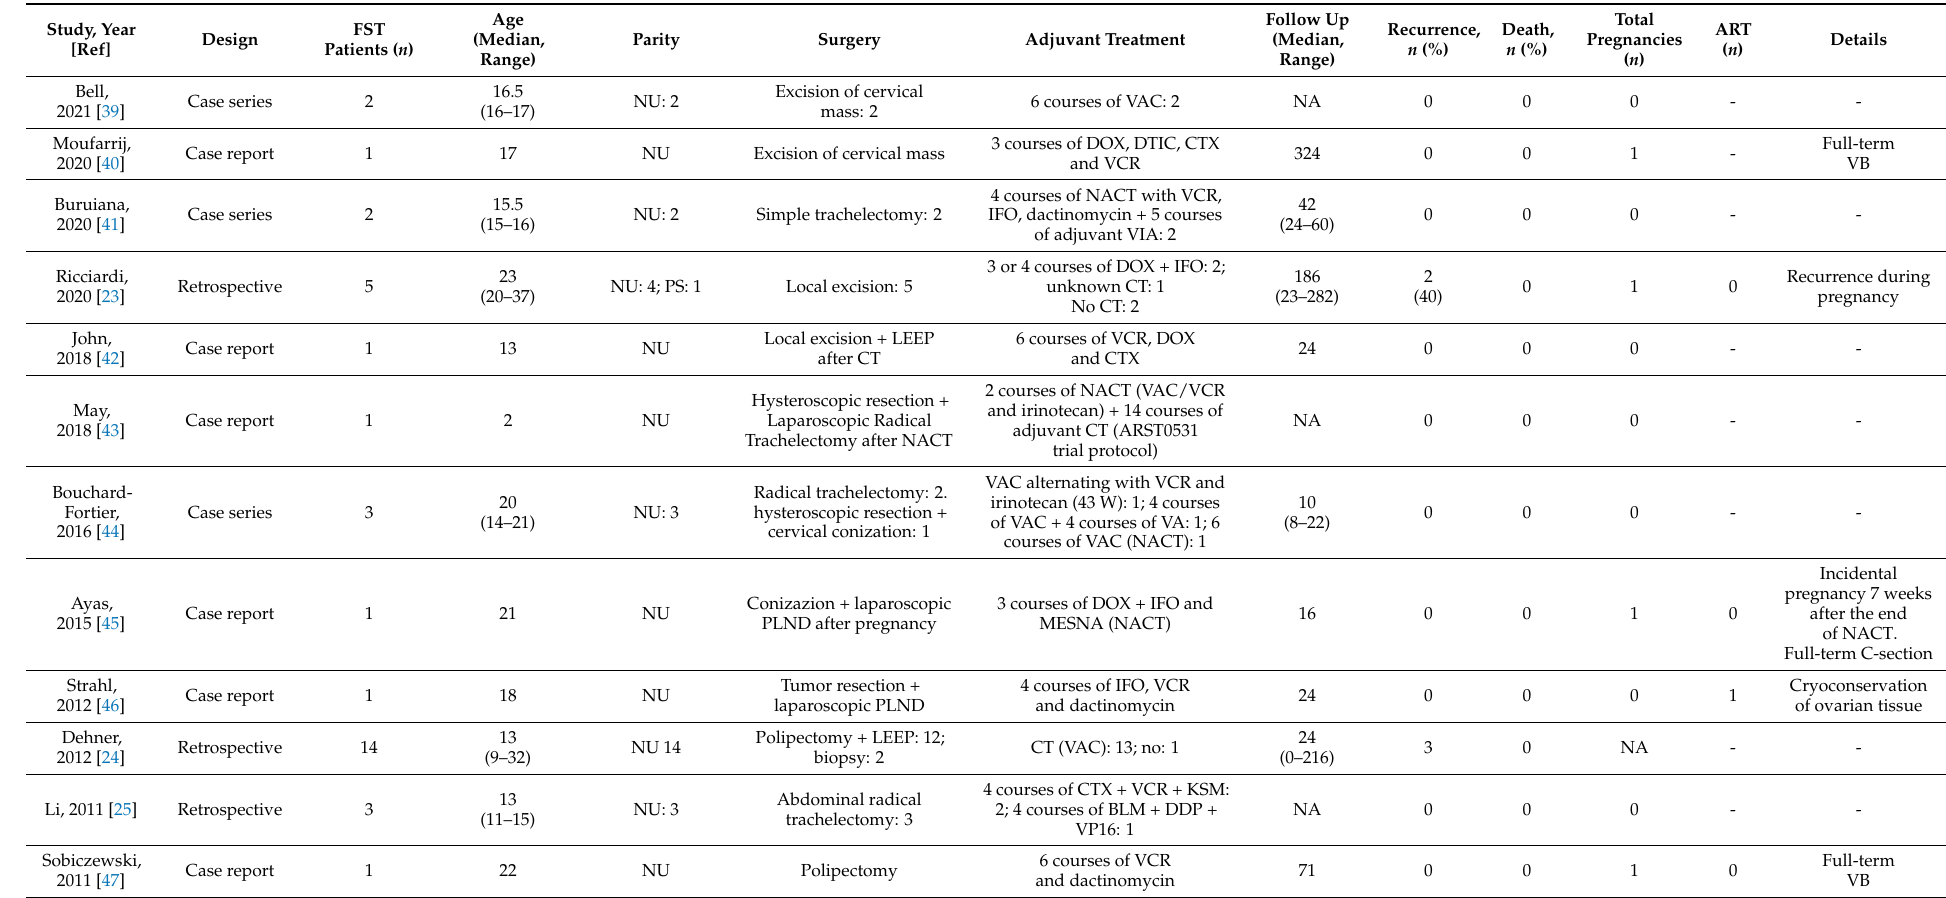
Table 7. Published reproductive and oncologic outcomes after FST of embryonal RMS of the uterine